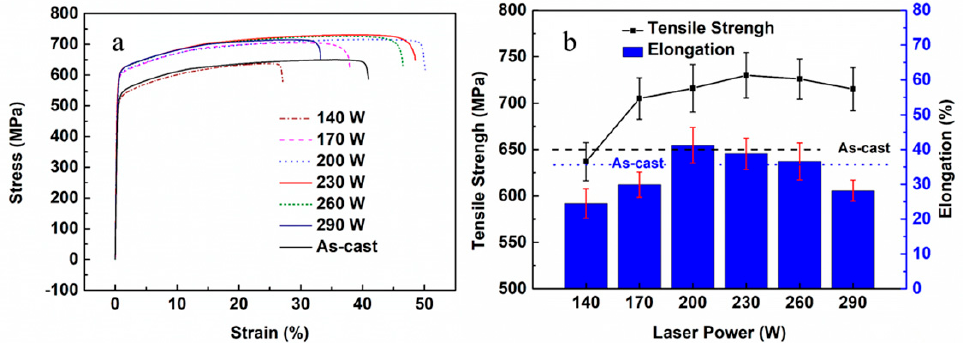
Figure 9. ( a ) Typical stress–strain curve of the 170 W samples, ( b ) tensile strength and elongation of the 316L stainless steel samples. Metals 2018 , 8 , x FOR PEER REVIEW